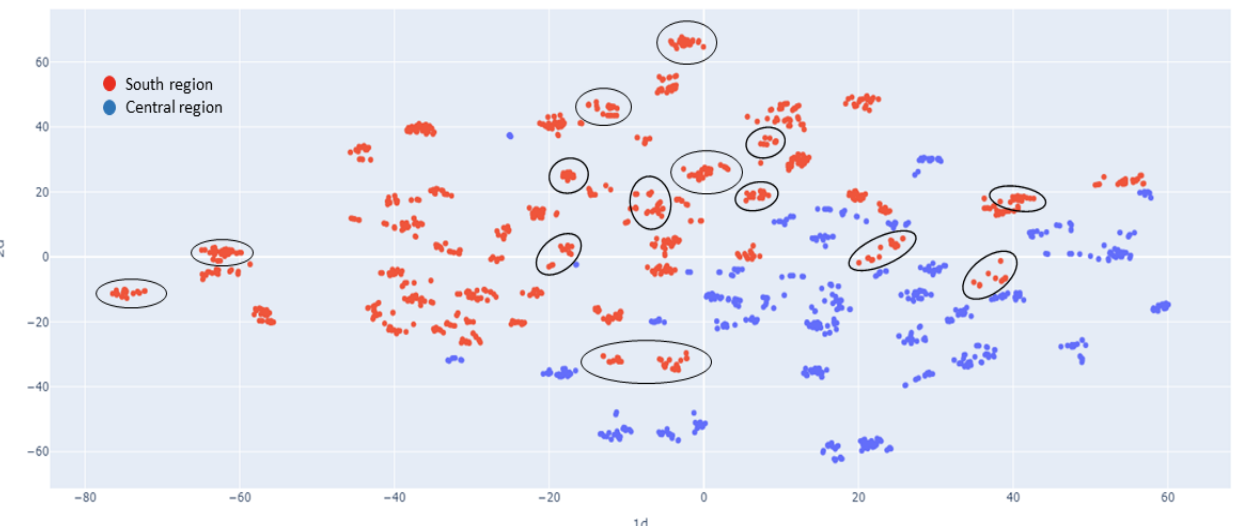
Table 4. Morphological traits comparison between managed and wild populations. Number of